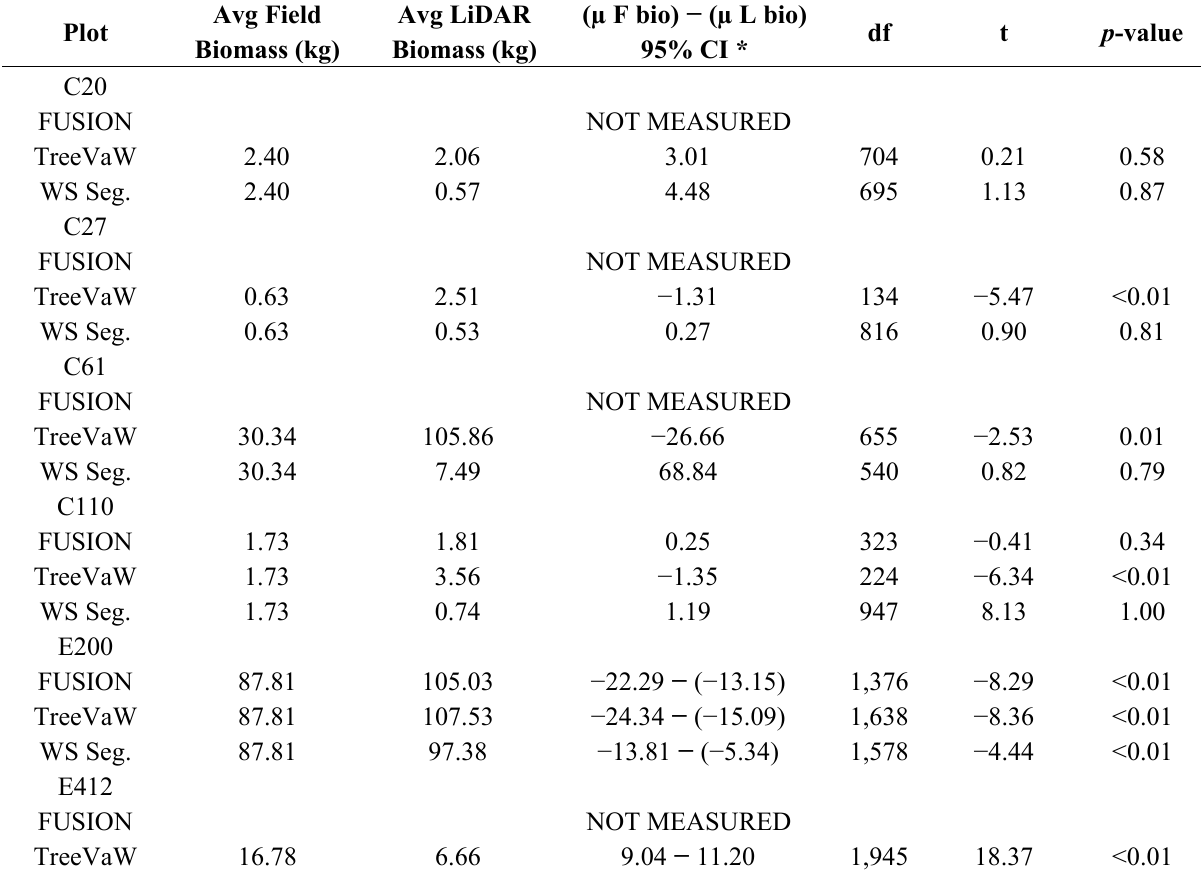
Table 15. Probability that LiDAR (L) based feature mean TAGB estimates by plot are equal to field (F) measurement